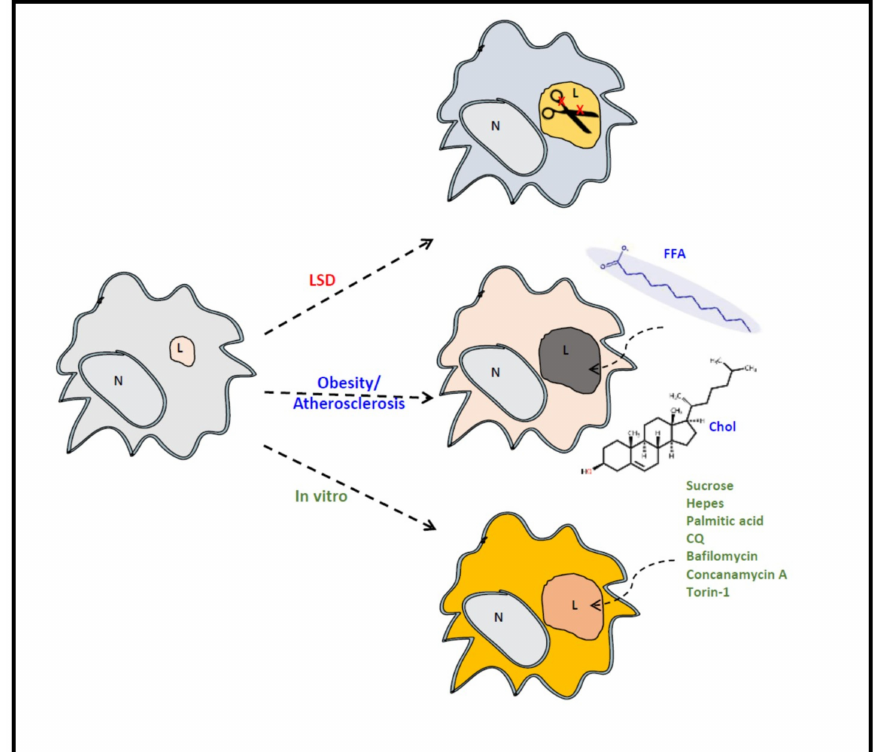
Figure 2. Model for lysosomal dysfunction in LSD, metabolic syndrome and cultured cells; lysosomal dysfunction could be caused in vivo by deficiencies in lysosomal hydrolases (LSD) or chronic excess of nutritional intake (metabolic syndrome). In vitro, lysosomal dysfunction can be recapitulated by several compounds that model in vivo systems. FFA, free fatty acid; Chol, cholesterol; CQ, chloroquine; N, nucleus; L,